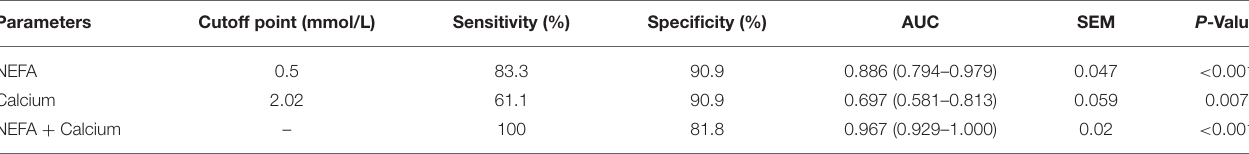
TABLE 4 | The cutoff point, sensitivity, specificity, standard error and area under the ROC curve of NEFA and Calcium diagnosed by ovarian diseases in dairy cows.